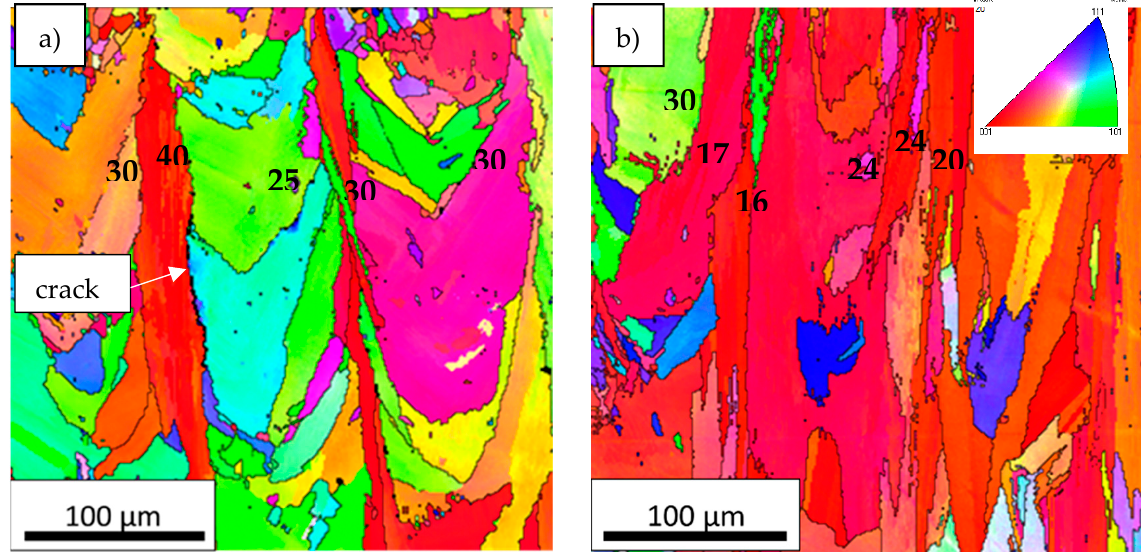
Figure 4. IPF images of ( a ) LPW and ( b ) A&D samples in building direction.